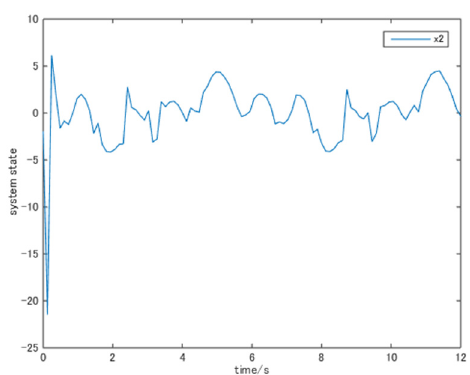
Figure 7. The trajectory of state x 2 ( t ) .